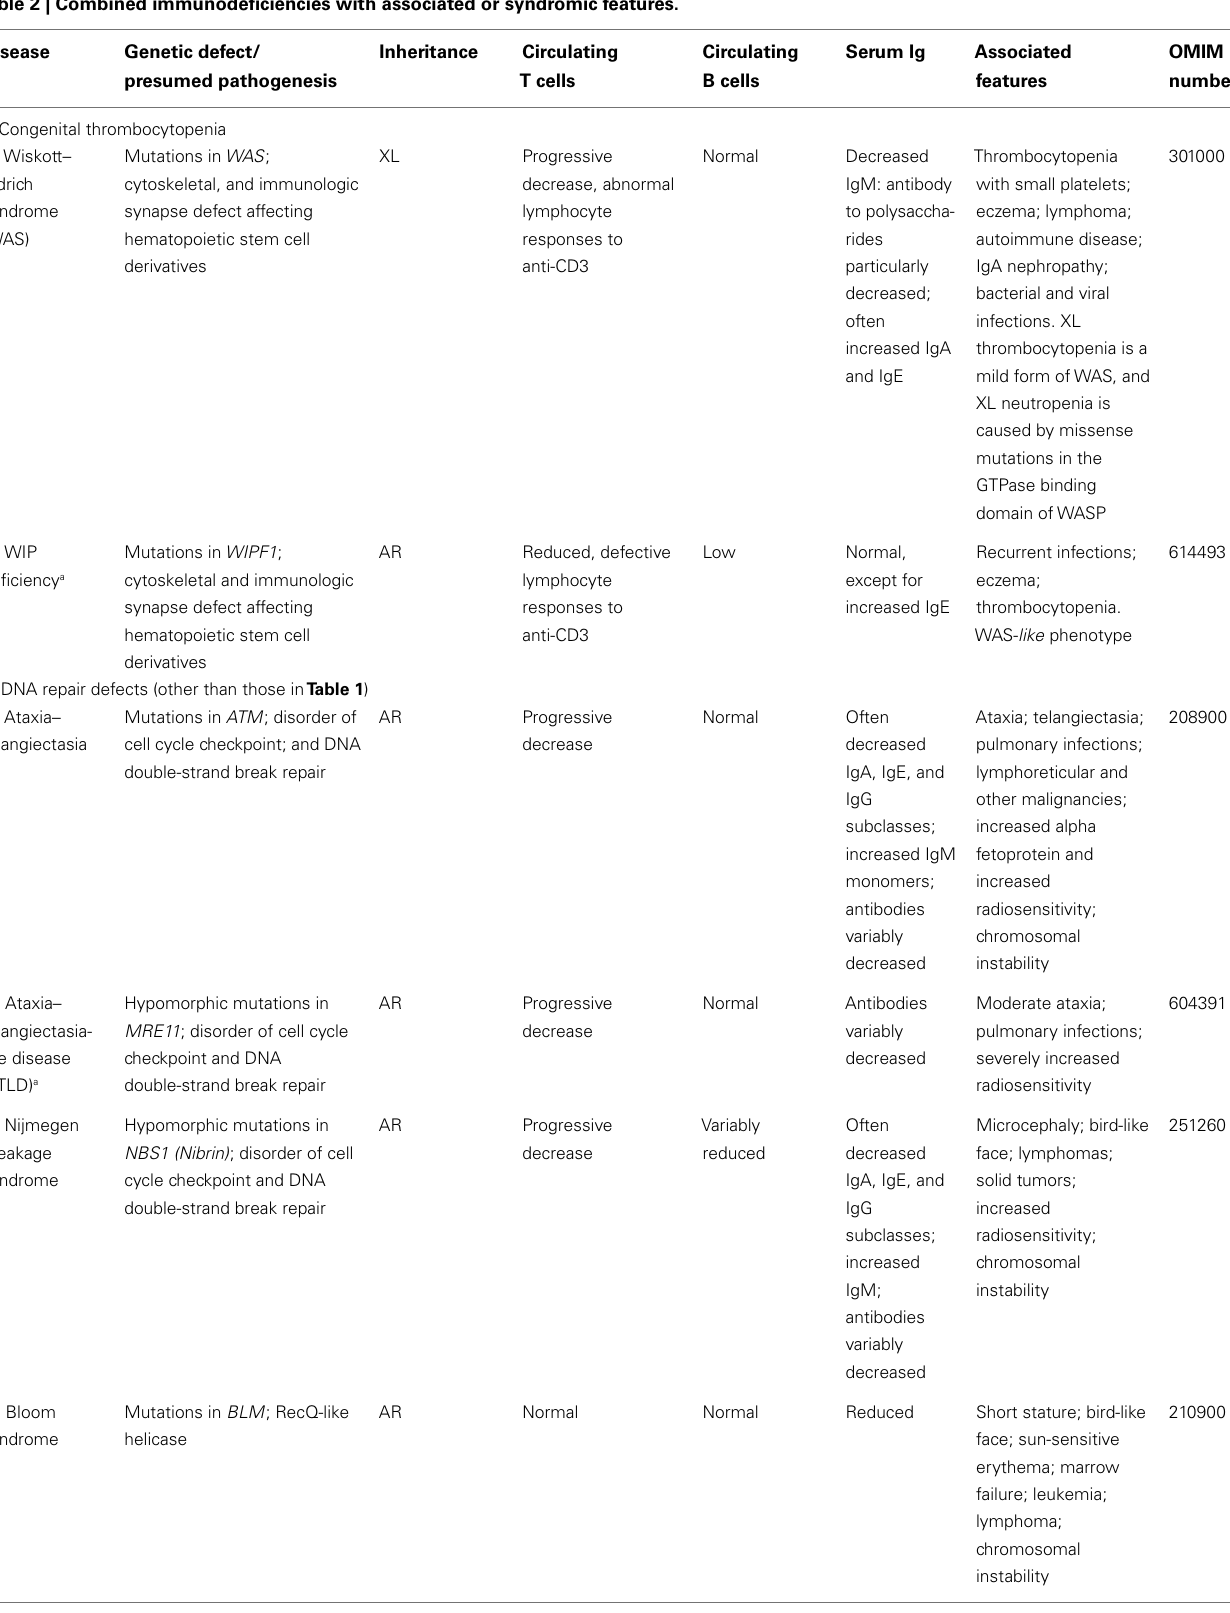
Table 2 | Combined immunodeficiencies with associated or syndromic